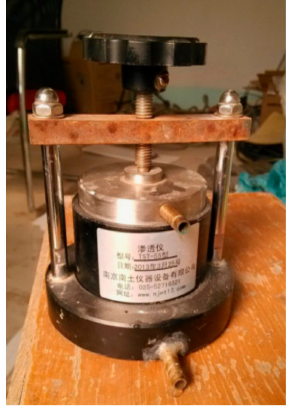
Figure 1. TST-55 permeameter. The TST-55 permeameter consisted of a cutting ring, two porous stones, a lantern ring, a top cover, a bottom cover, two rubber rings, and secured with bolts and